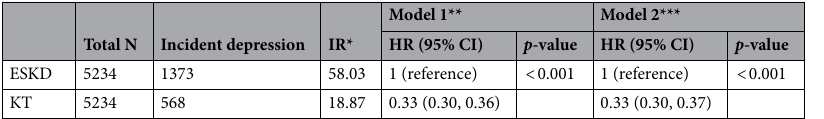
Table 2. Incidence rate and risk of depression in ESKD and KT groups. *IR: incidence rate per 1000 person- years. **Model 1 was adjusted for age and sex. ***Model 2 was adjusted for age, sex, income level, presence of hypertension, diabetes mellitus and dyslipidemia, CCI score, and RRT duration. ESKD end-stage kidney disease, KT kidney